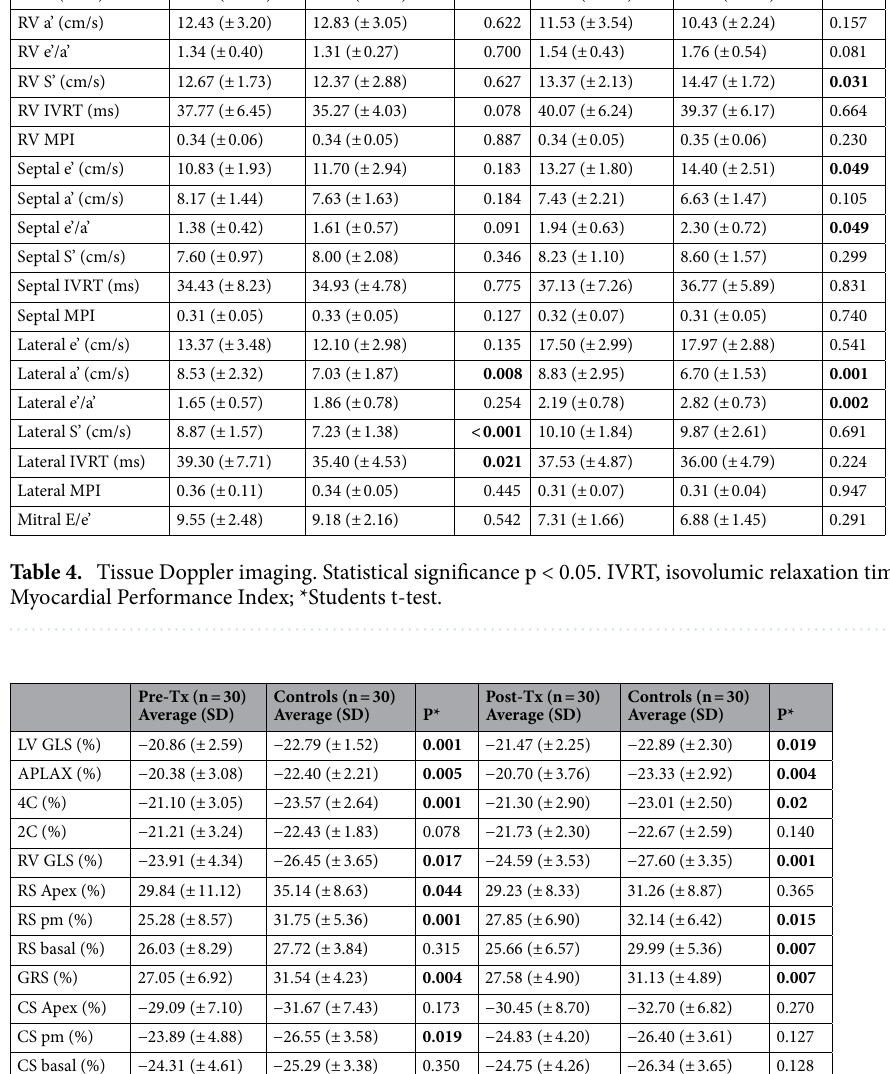
Evaluation through two-dimensional speckle tracking. Patients in pre-transplant group had a signif- icant reduction in the parameters of left ventricular longitudinal myocardial deformation as shown in Table 5. The global longitudinal strain (GLS) of left ventricle was significantly lower in pre-transplant patients (−20.86 ± 2.59 vs. −22.79 ± 1.52%, p = 0.001) than controls. When analyzed separately from each window, a significant reduction of longitudinal strain was observed in the three-chamber (APLAX) (−20.38 ± 3.08 vs. −22.40 ± 1.52%, p = 0.005) and in the apical four chambers (4C) (−21.10 ± 3.05 vs. −23.57 ± 2.64%, p = 0.001). The GLS of the right ventricle also showed a significant reduction in the pre-transplant group (−23.91 ± 4.34 vs. −26.45 ± 3.65%, p = 0.017). The